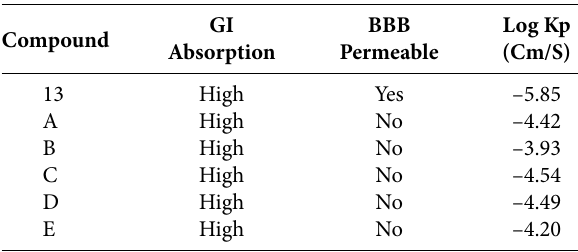
Table 6. Predicted ADME properties for new